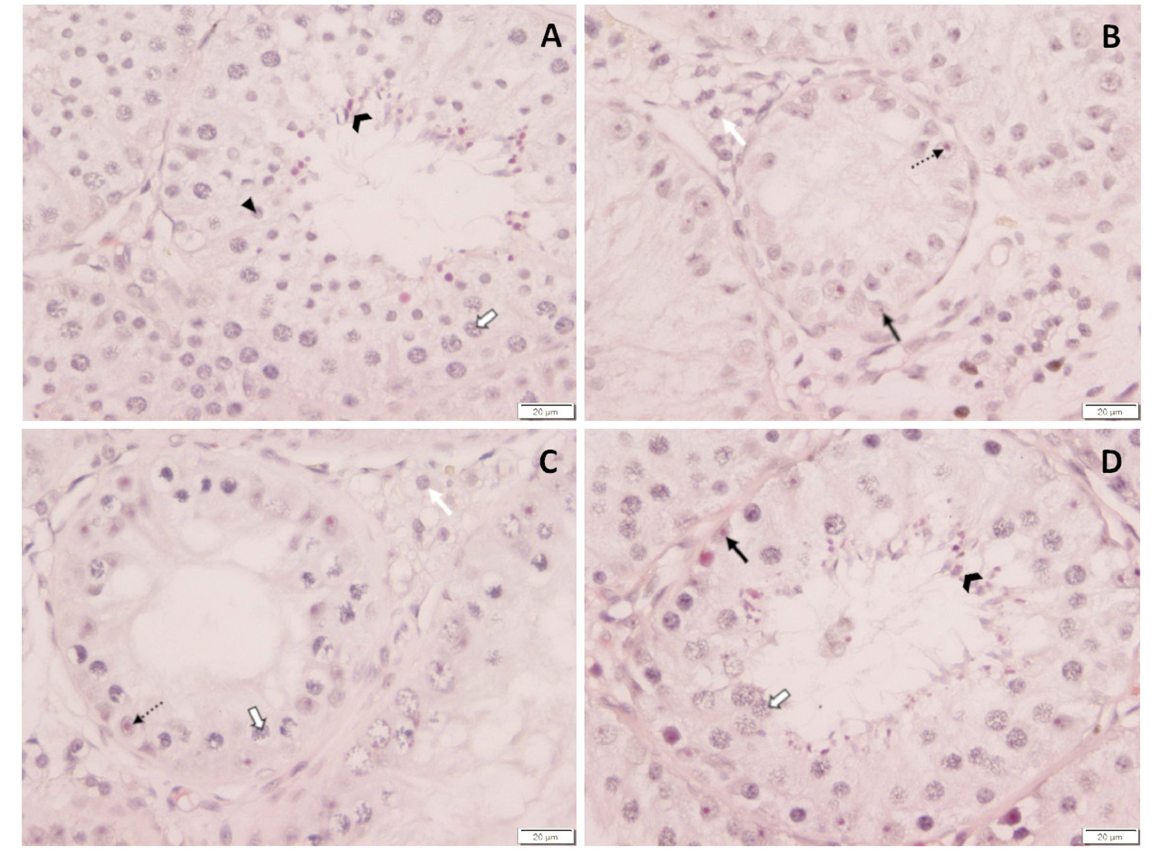
IHC revealed specific immunopositive staining against Vimentin located in the cyto- plasm of Sertoli cells in the seminiferous tubules in all groups (Figure 13). Sertoli cell nu- clei were round to ovoid and frequently detached from the basal membrane in four of six deslorelin-treated dogs, concomitant with spermatogenesis arrested at the level of sper- matogonia. Different to this, Sertoli cell nuclei were polygonal and positioned close to the basal membrane in dogs with full spermatogenesis, independent of saline and reversed deslorelin treatment (n=1). Figure 13. Immunopositive staining of testicular tissues against Vimentin. ( A ) Saline-treated control dog and ( B – D ) deslorelin-treated dogs. ( A ) Normal spermatogenesis. ( B ) Arrest of spermatogenesis at the level of spermatogonia. ( C ) Arrest of spermatogenesis at the level of spermatocytes. ( D ) Re- versed effects of treatment as indicated by normal spermatogenesis and spermatozoa in the semen sample on D147 after treatment; IK: isotype control; spermatogonia; spermatocytes; round spermatids; elongated spermatids; Sertoli cells; white arrow, Leydig cells. 3.6.2. DAZL protein expression